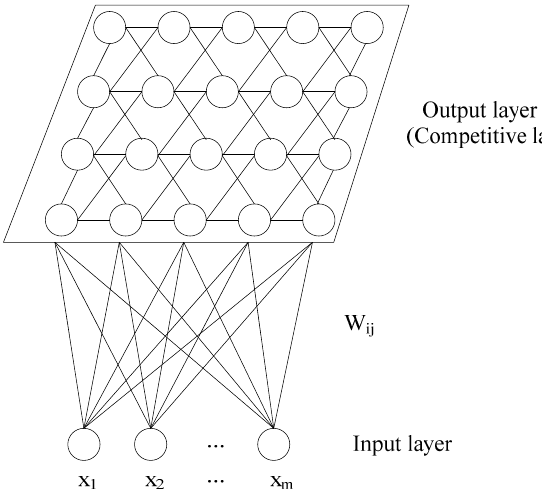
Figure 2. Topological structure of SOM.